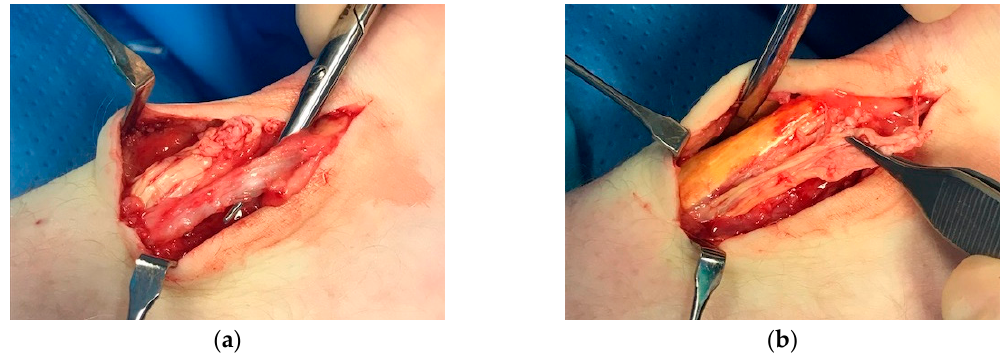
Figure 4. Patient with a partial rupture in close relation to a thick and compressing plantaris tendon: ( a ) thickened plantaris tendon compressing onto the medial side of the Achilles; ( b ) surgical release of the compressing plantaris tendon.